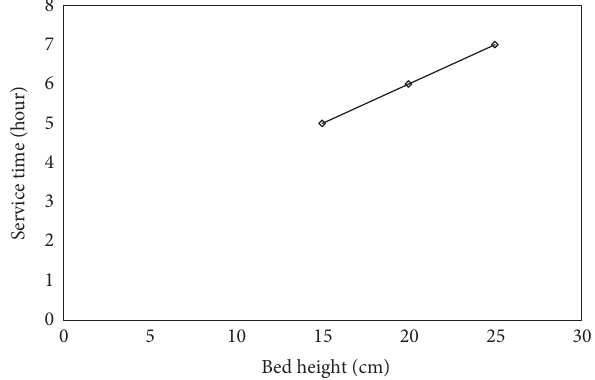
F 6: Effect of �ow rate on breakthrough curve for Cr(VI) ion F 8: Effect of initial concentration on breakthrough curve for , bed height = 25cm). adsorption on EAM-CCRCBs ( Cr(VI) ion adsorption on EAM-CCRCBs (bed height = 25cm, �ow rate = 25mL/min). 𝐶𝐶 0 = 300